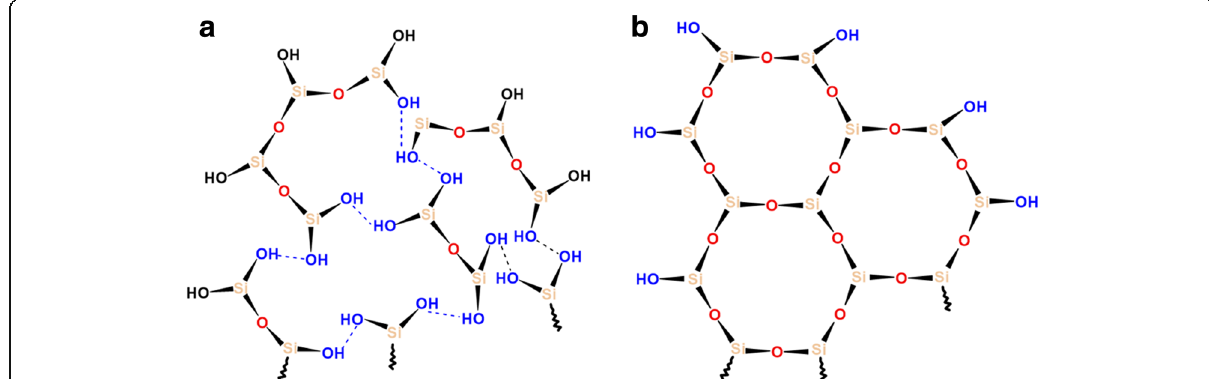
Fig. 6 The amorphous-like structure ( a ) consists of the molecules bonded via Si-O-Si and Si-OH·····HO-Si bonds, proposed in [11] and ( b ) the crystalline-like structure has “ extended ” Si-O-Si bonds, proposed in [11, 38 – 41]